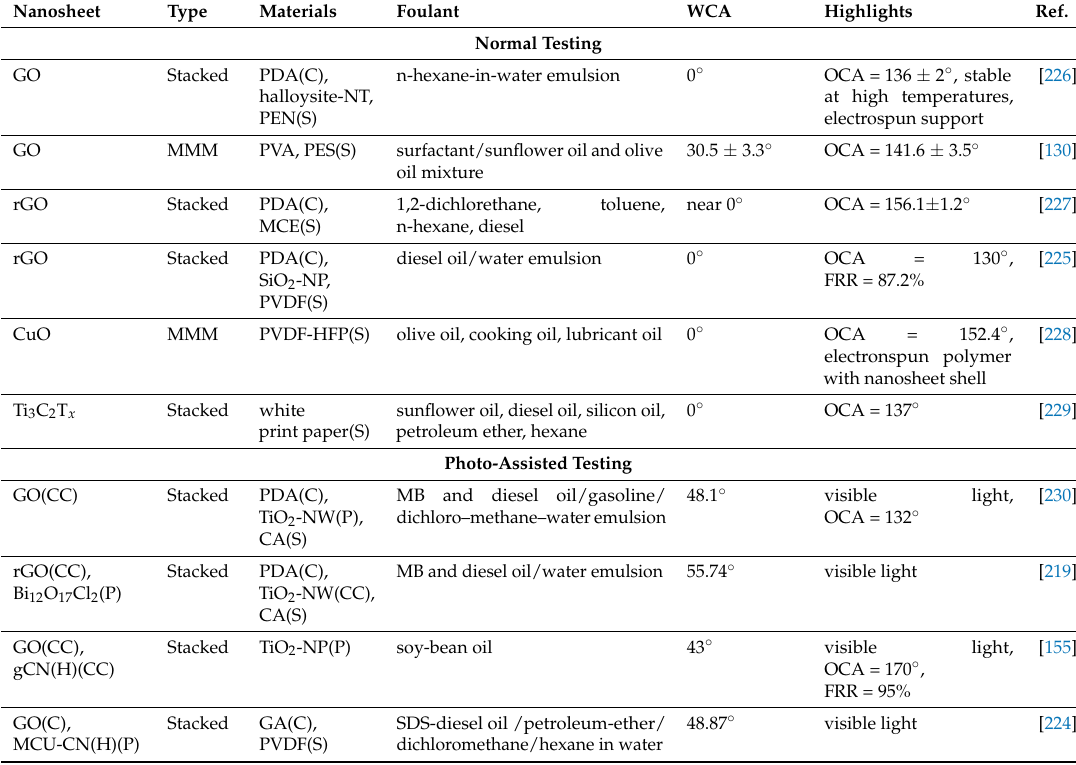
Table 3. Nanosheet Membranes to mitigate spreadable